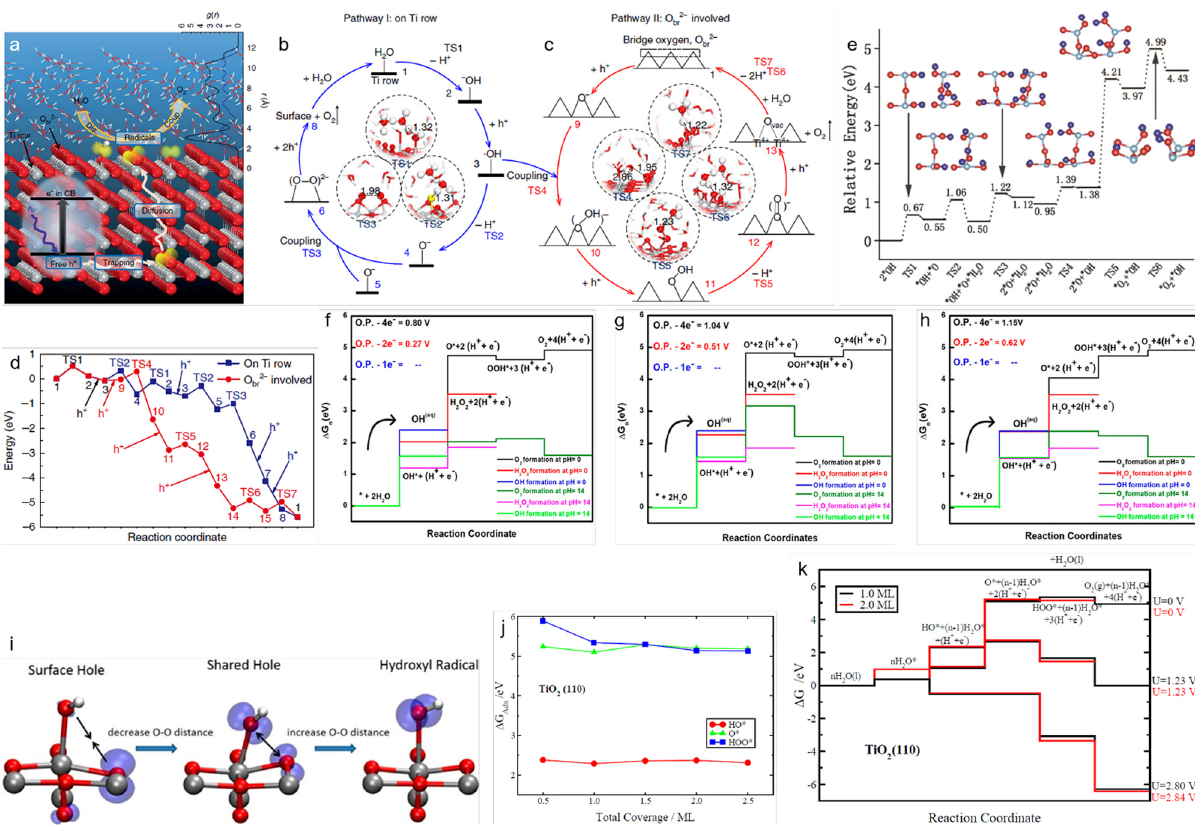
Figure 5: ( a ) Schematic of the photocatalytic OER at the water/TiO 2 interface and proposed mechanism of the dual pathways for photo - catalytic OER: ( b ) pathway I: occurring on the Ti row and ( c ) pathway II: involving bridge oxygen. ( d ) The energy pro fi les of pathways I and II, reprinted with permission from ref. [ 158 ] , Copyright ( 2018 ) Springer Nature. ( e ) Calculated potential energy pro fi les of these elementary steps during H 2 O oxidation to O 2 on the unreconstructed TiO 2 ( 001 ) surface, reprinted with permission from ref. [ 161 ] , Copyright ( 2020 ) Royal Society of Chemistry. Free energy diagrams for the OER through peroxo O2* species on ( f ) TiO 2 rutile ( 110 ) , ( g ) anatase ( 101 ) , and ( h ) brookite ( 210 ) phases, reprinted with permission from ref. [ 16 ] , Copyright ( 2020 ) American Chemical Society. ( i ) The rate - limiting steps in the water - splitting reaction process on the TiO 2 surface, reprinted with permission from ref. [ 164 ] Copyright ( 2013 ) American Chemical Society. ( j ) Calculated free energy for OER intermediates as a function of total coverage and ( k ) calculated free energy diagram for OER on the defect - free TiO 2 ( 110 ) surface covered with water, reprinted with permission from ref. [ 165 ] , Copyright ( 2014 ) American Chemical